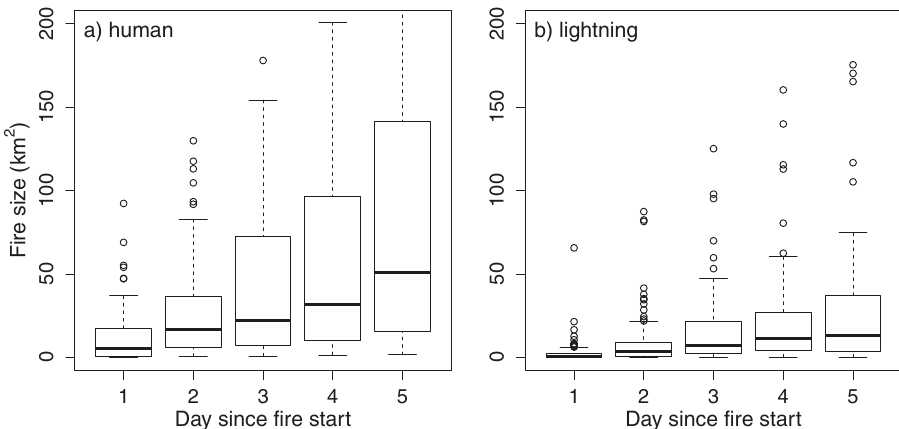
Fig. 1 Initial fi re size during the fi rst 5 days after ignition. Boxplots of the fi re size at the end of day 1 through day 5 after ignition for fi res caused by humans ( a ) or lightning ( b ) in California. The y -axis is cutoff at 200 km 2 to enable visualization of median differences; the full fi gure is shown as Supplementary Fig. 4. Differences between the two fi re types are signi fi cant for each day (Welch Two-Sample t -test, day 1: t = 6.51, p = 8.27e − 10 ; day 2: t = 6.98, p = 1.20e − 10 ; day 3: t = 5.37, p = 3.29e − 7 ; day 4: t = 4.62, p = 9.47e − 6 ; day 5: t = 4.93, p = 3.089e − 06 ). The sample size n = 82, 79, 67, 58, 44 from day 1-5 in panel a and n = 90, 82, 77, 67, 64 from day 1 – 5 in panel b . The Boxplot represent the fi rst quartile, the median, and the third quartile as a box, with the whiskers denote the minimum and maximum if within the range of the fi rst quartile − 1.5× the interquartile range and the third quartile + 1.5× the interquartile range, while outliers are represented as points.